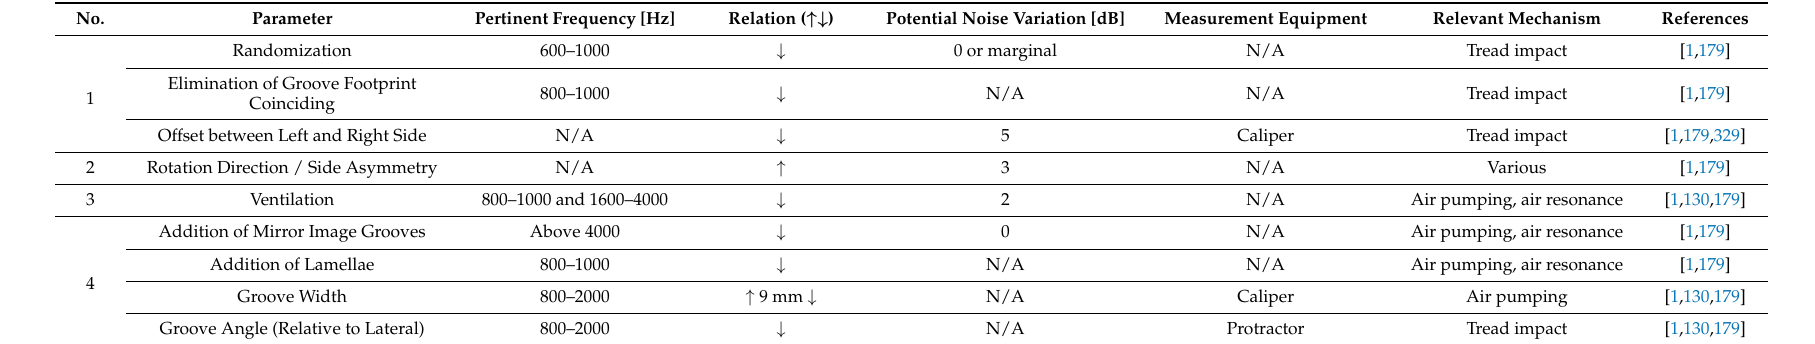
Table 17. Summary of tread pattern parameters affecting TPIN.